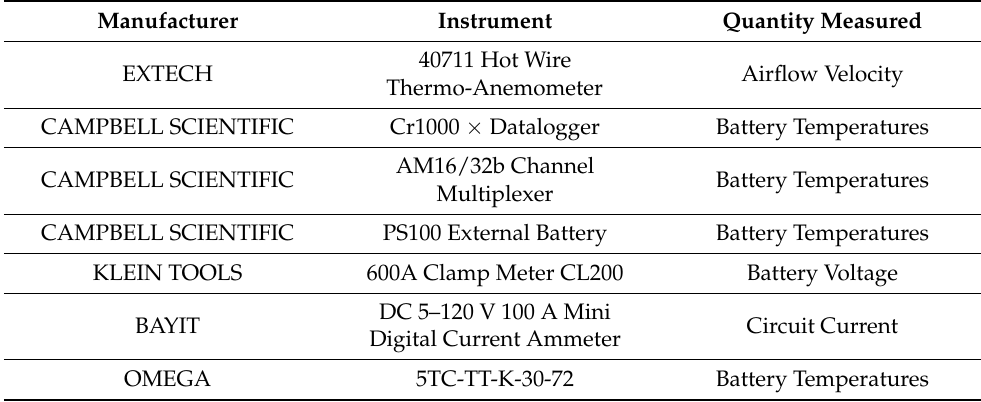
Table 1. Instruments paired with variables measured within the data collection process.